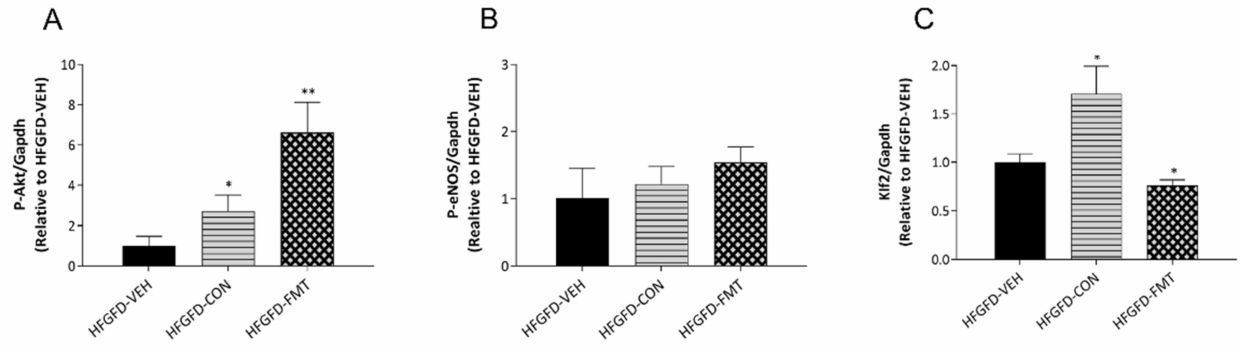
Figure 3. Expression of markers of endothelial dysfunction in NASH rats. ( A – C ) Western blot analysis of intrahepatic markers of endothelial dysfunction. Bar diagrams show the quantification of phosphorylated (P)-Akt, P-eNOS, and Klf2 using glyceraldehyde 3-phosphate dehydrogenase (Gapdh) as a loading control and normalized to the HFGFD-VEH group. HFGFD-VEH: group of NASH rats receiving sham gavage (vehicle); HFGFD-CON: group of NASH rats receiving the 9-strain bacterial consortium daily; HFGFD-FMT: group of NASH rats receiving fecal microbiota transplantation from control lean rats (1 × transplantation followed by sham gavage). Abbrevia- tions: Akt, Protein kinase B; eNOS, Endothelial nitric oxide synthase; Klf2, Kruppel-Like Factor 2. *, ** p ≤ 0.05 and ≤ 0.01, respectively, versus HFGFD-VEH.